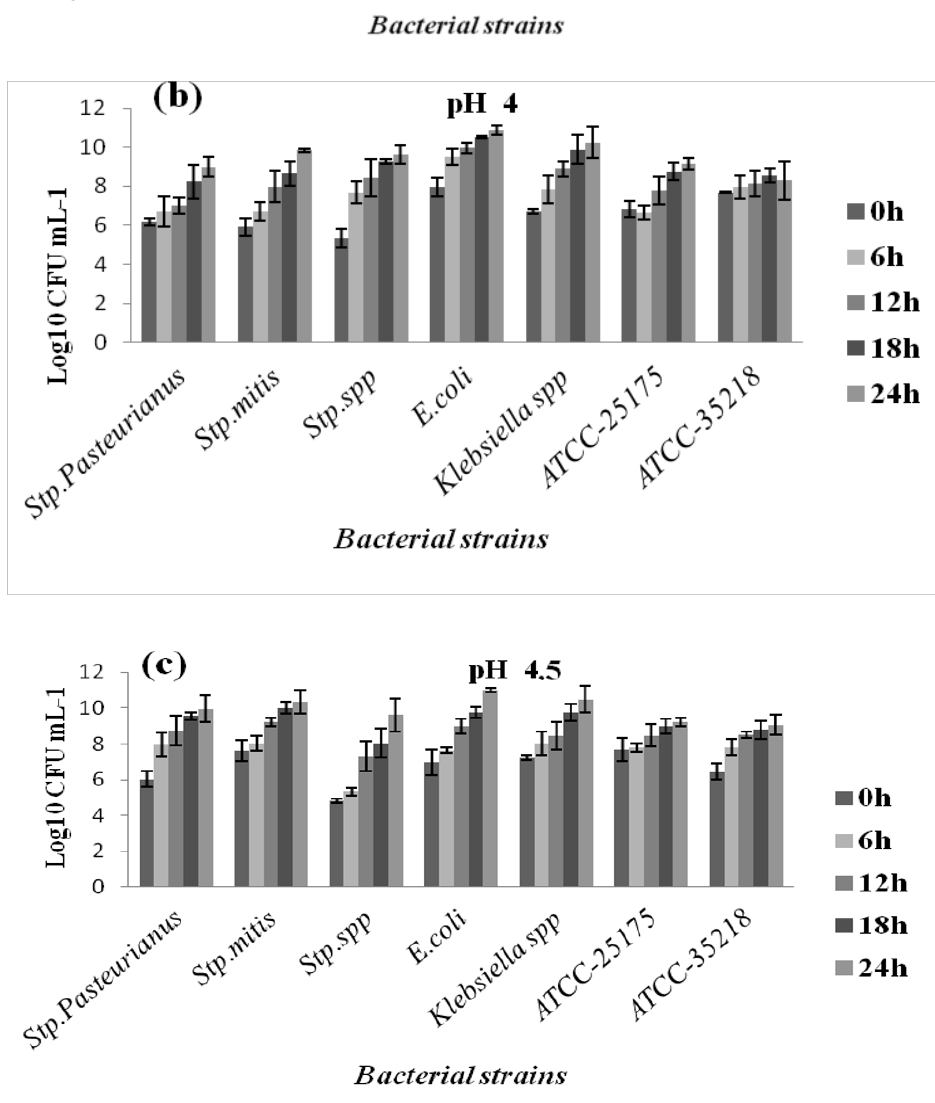
Figure 7. Growth of vaginal streptococcus, E. coli, and Klebsiella spp. strains at pH 3.5 ( a ); pH 4 ( b ); and pH 4.5 ( c ).